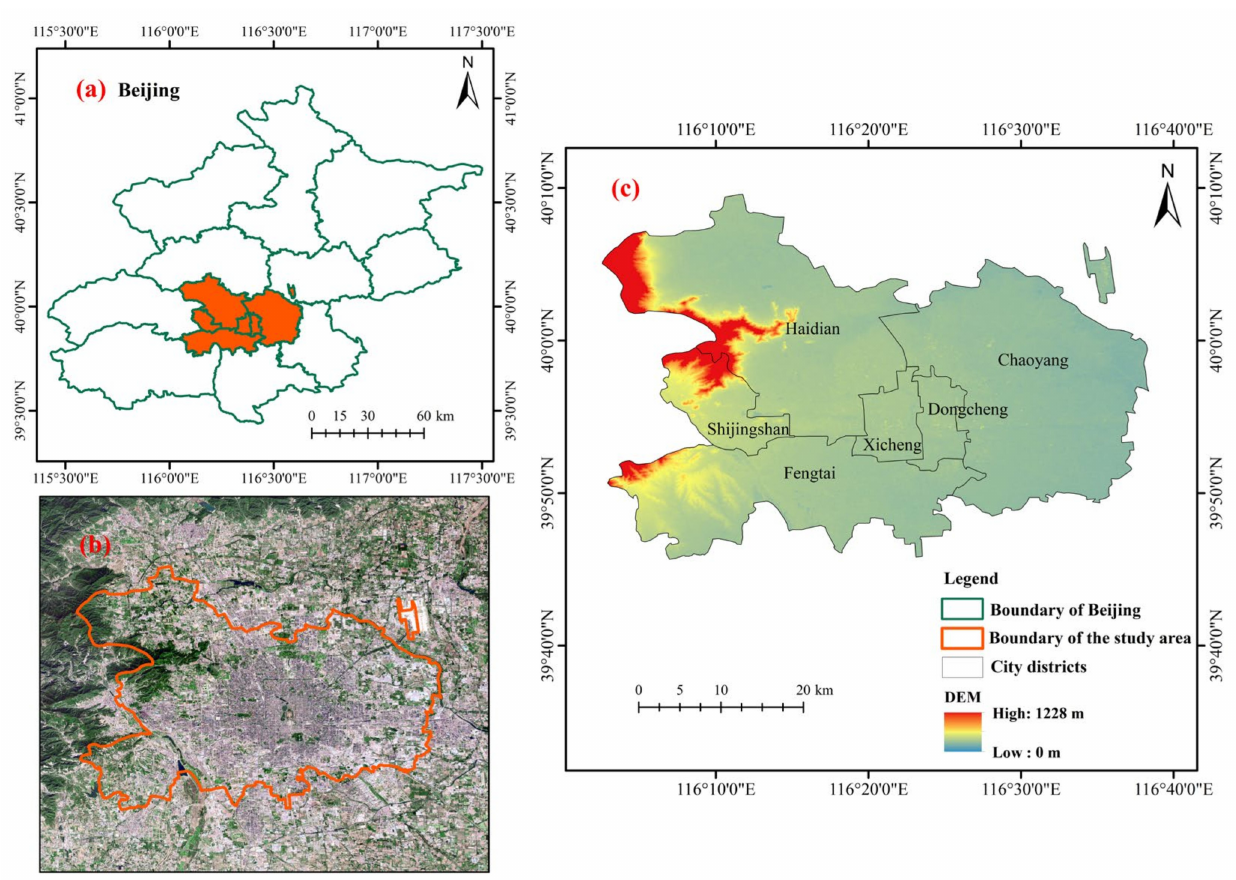
Figure 1. Study area. ( a ) the study area is located in the center of Beijing; ( b ) the background image is a Sentinel-2 image captured on 10 August of 2020, projected in WGS84, in true color (R = band 4, G = band 3, and B = B2), with a spatial resolution of 10 m; ( c ) the digital elevation model (DEM) at 30 m spatial resolution and the distribution of the six districts—the small enclave located in the northeast of the research area is Beijing Capital International Airport, managed by Chaoyang